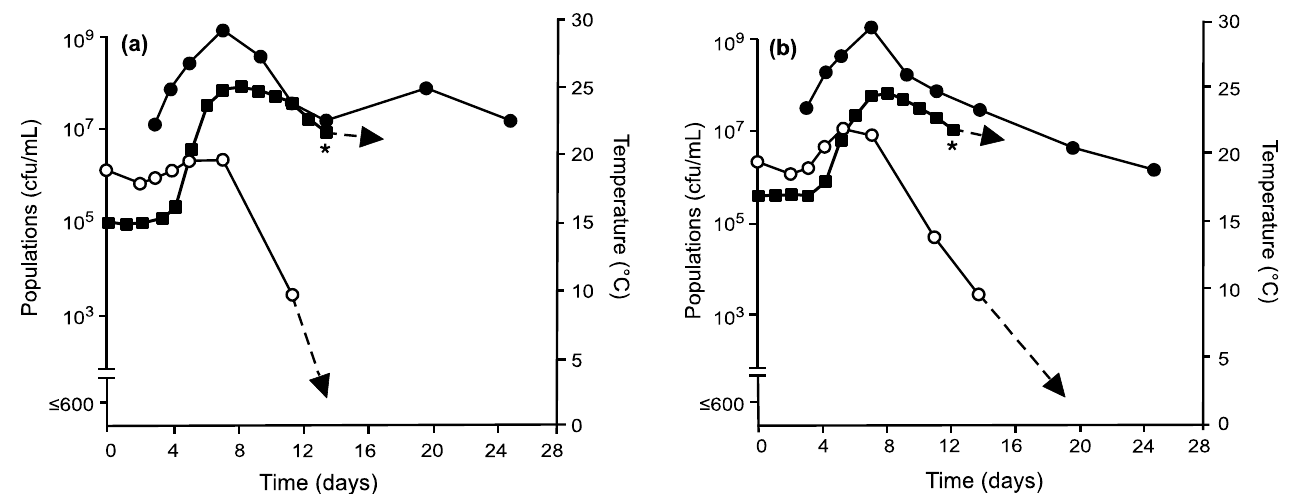
Figure 2. Culturable populations of S. cerevisiae ( ), total non- Saccharomyces yeasts ( ), and fermen- tation temperatures ( ) in grape musts inoculated on day 0 with Mt. pulcherrima prior to inoculation with S. cerevisiae on day 3 and following fermentation temperature regime II ( a ) or III ( b ). * Denotes time when the wine was pressed (approximately 0° Brix) prior to storage at 21 °C.